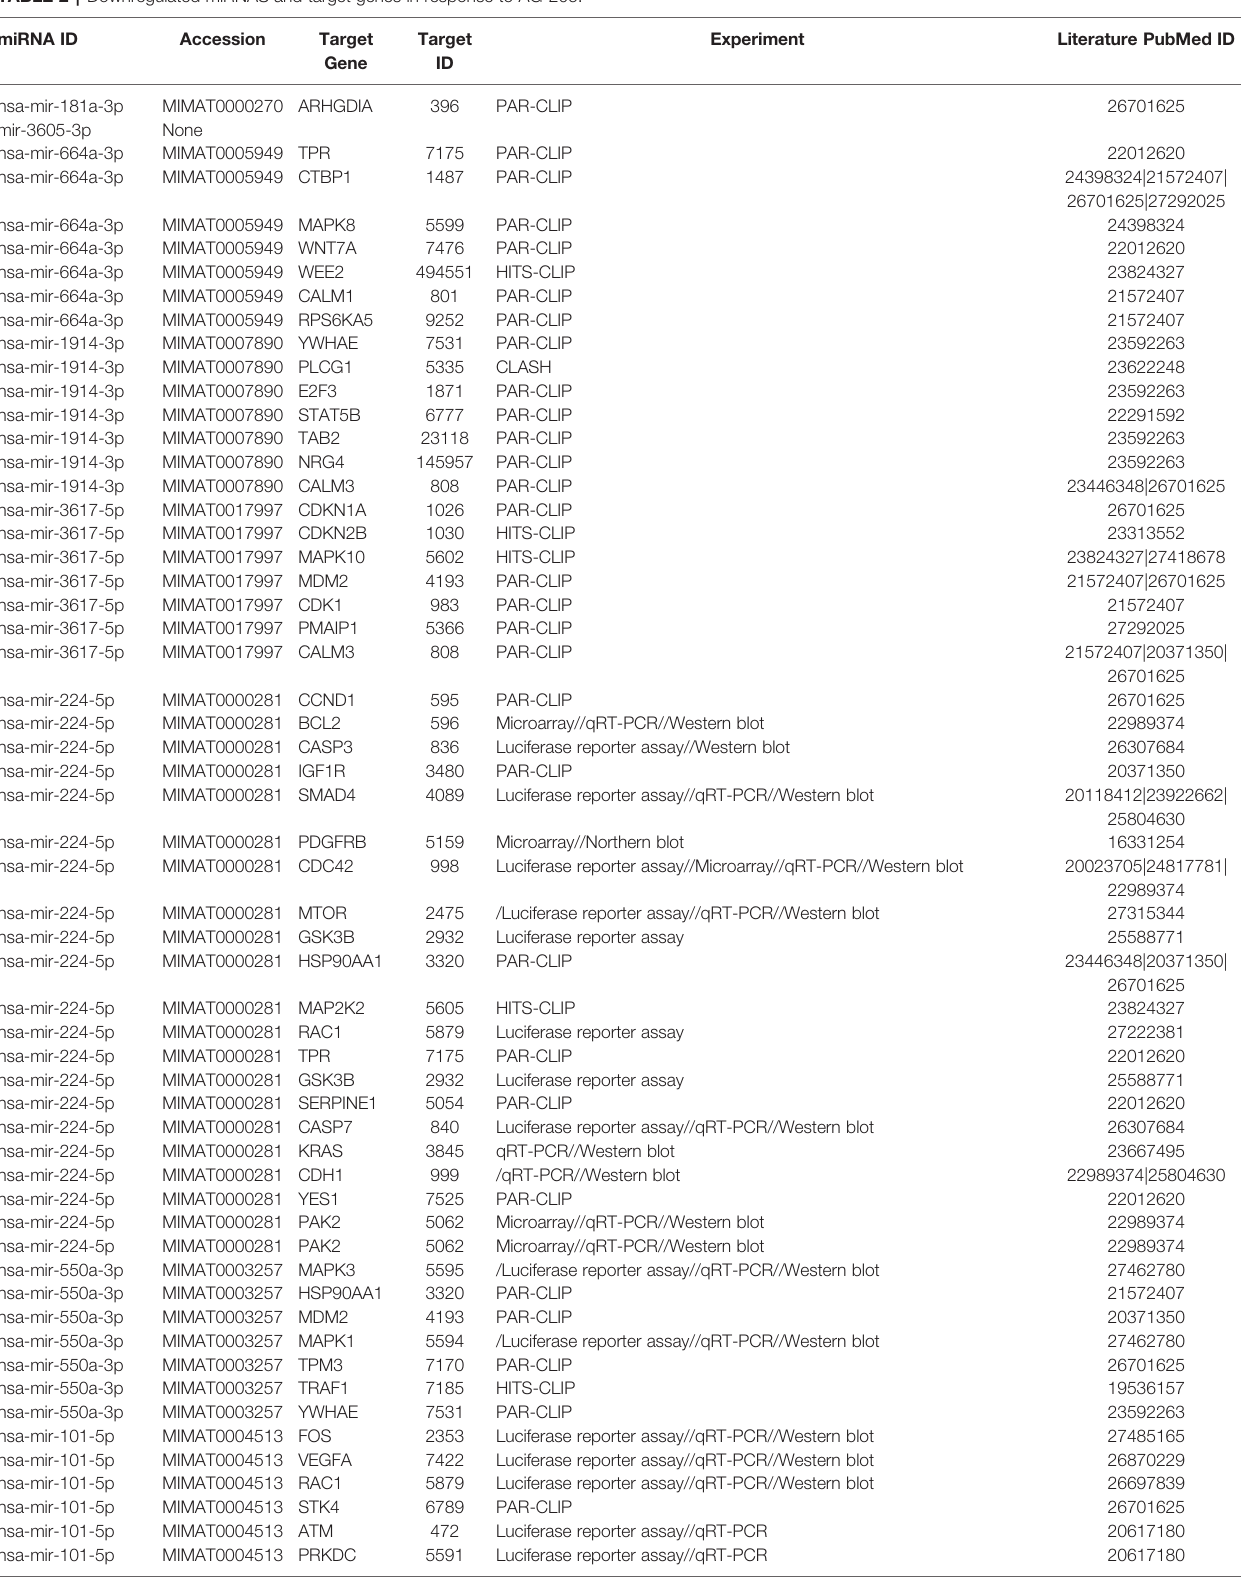
TABLE 2 | Downregulated miRNAS and target genes in response to